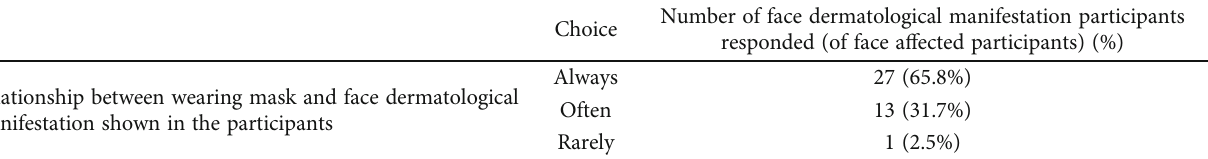
Table 2: The relationship between wearing a mask and face dermatological manifestation shown in the 43